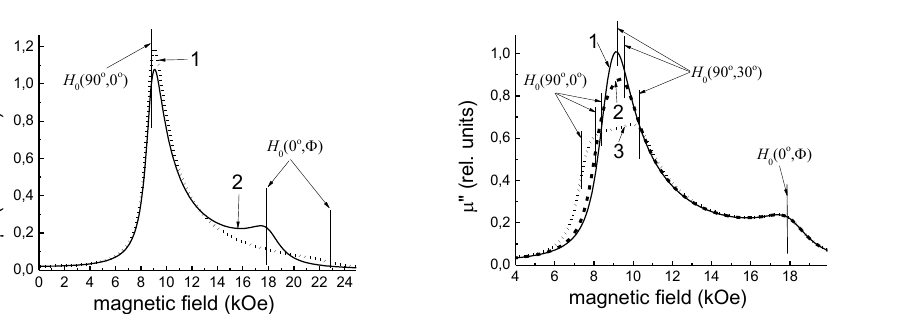
Fig. 2. Resonance curves of polycrystalline hexaferrite with EMP. Curve 1 : H a1 = – 5 kOe, H a2 = – 5 kOe, H a3 = 0 kOe, H Φ =0.5 kOe. Curve 2: H a1 = – 5 kOe , H a2 = – 5 kOe , H a3 = 0 kOe , H Φ =1 kOe . Curve 3: H a1 = – 5 kOe , H a2 = – 5 kOe , H a3 = 0 kOe , H Φ =2 kOe .